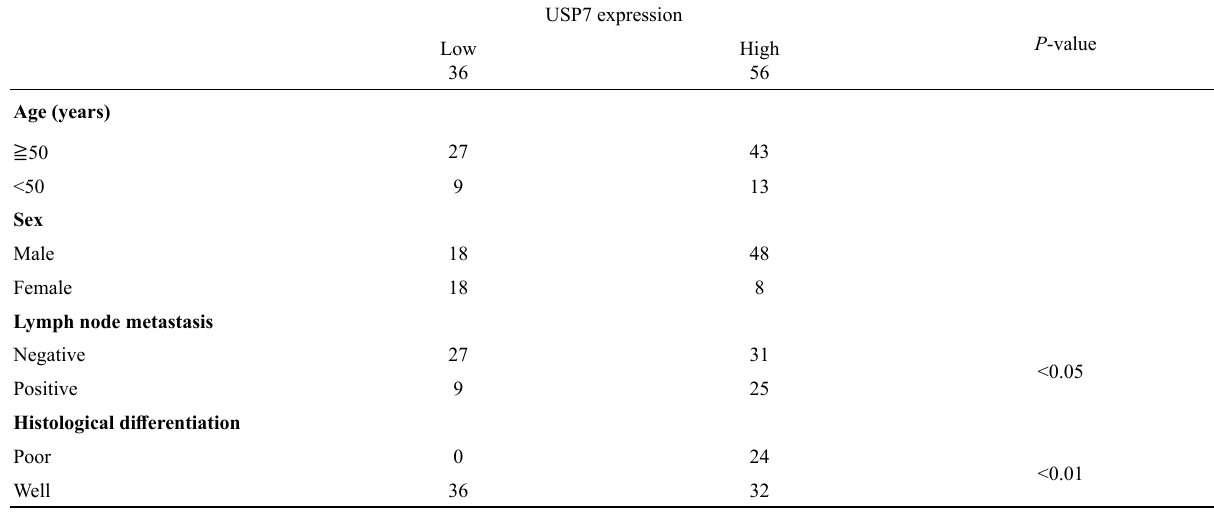
Table 3 – USP7 expression and its correlation with clinicopathological features in OSCC cases.